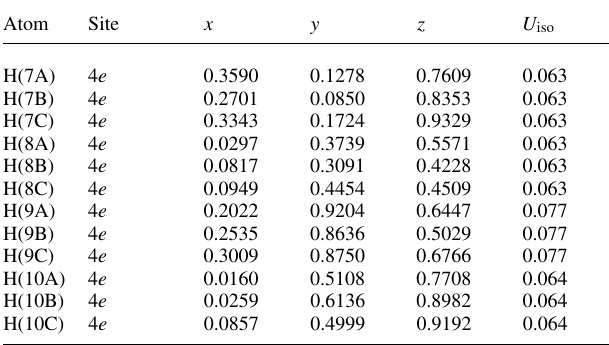
Table 2. Atomic coordinates and displacement parameters (in Å 2 )